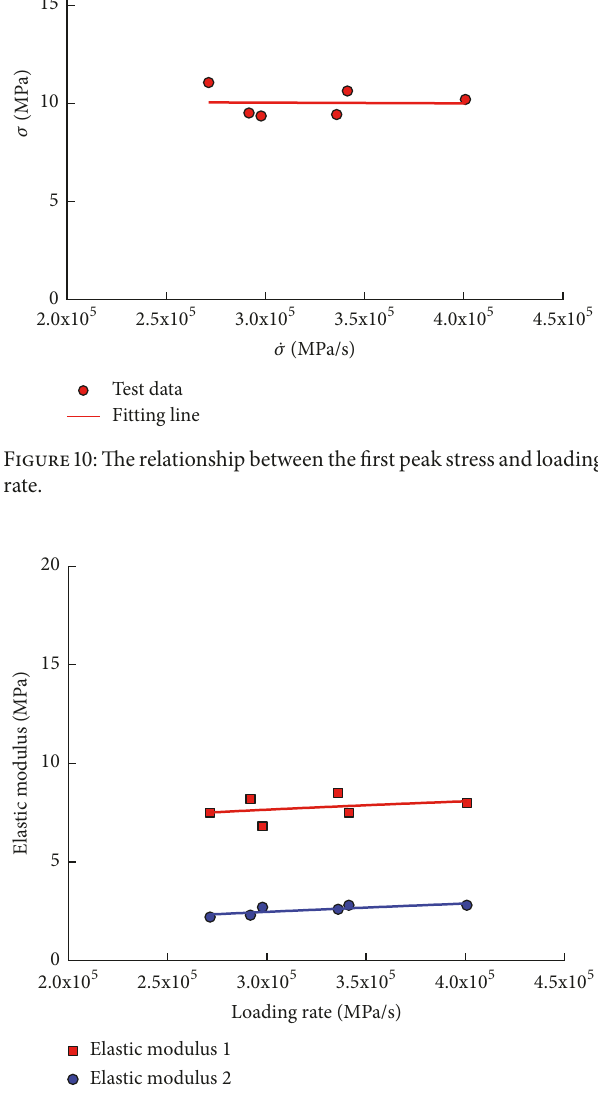
Figure11:Comparisonoftwoelasticmoduliunderdifferentloading rates.